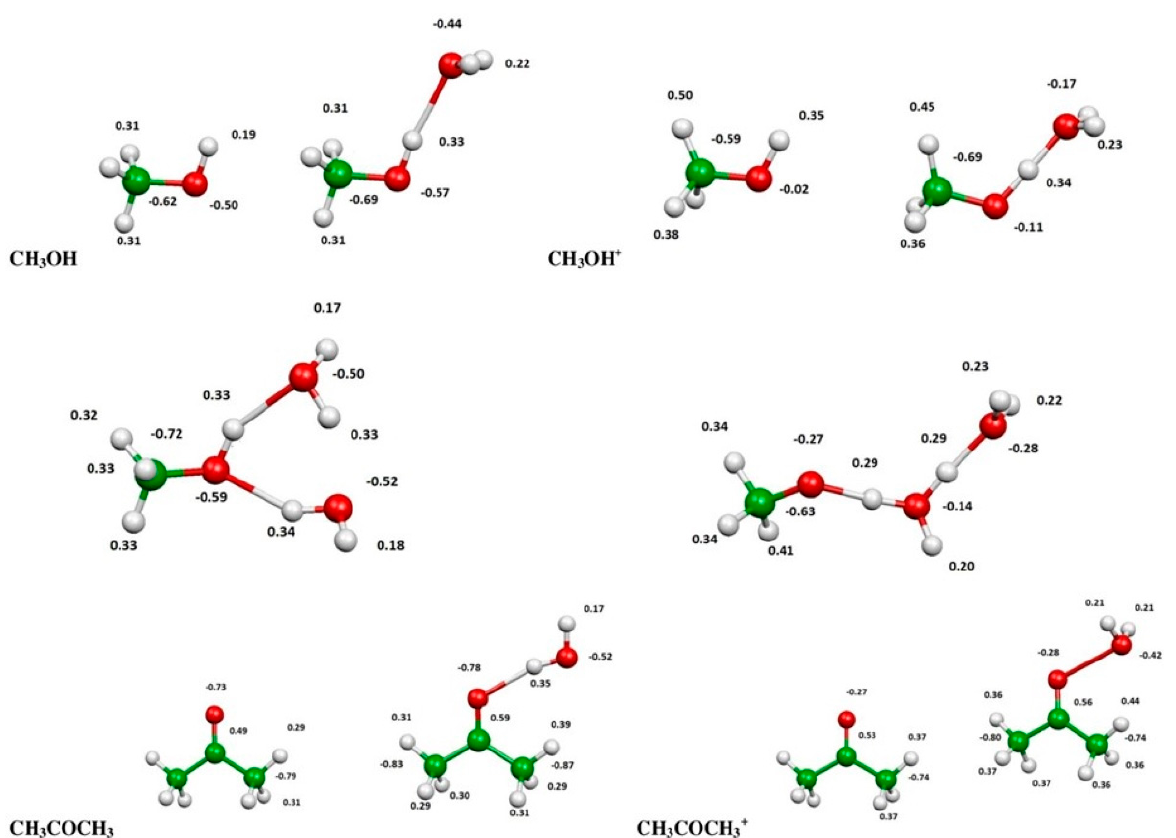
Figure 9. Calculated Mulliken charges for methanol and acetone neutrals and radical cations with and without surrounding water molecules.